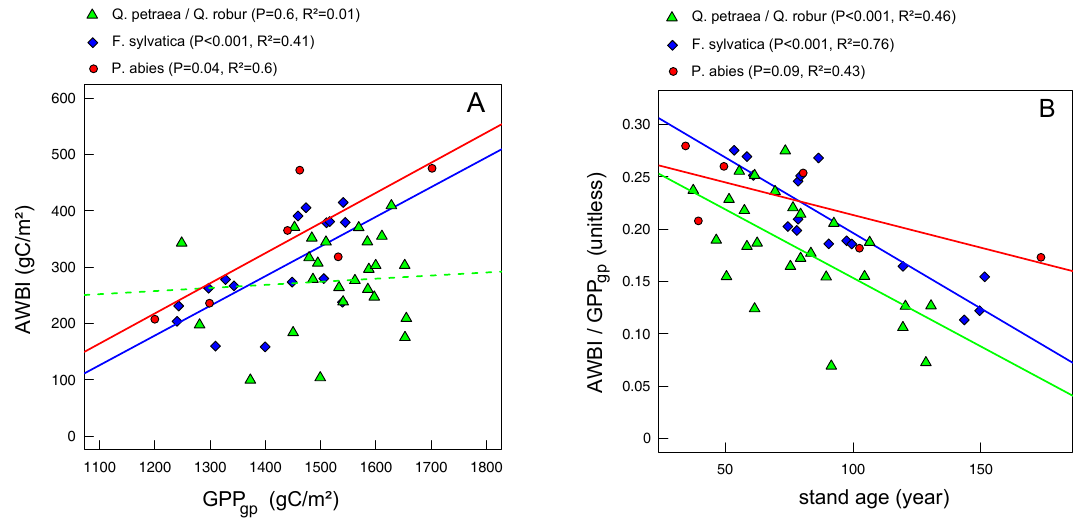
Figure 3. Spatial dependences of annual wood growth. (a) Relationship of the AWBI and the GPP of the growth period (GPP gp ) averaged over sites. (b) Age-related decline of the C partitioning to AWBI (AWBI / GPP gp ). Table 5. Temporal dependences of the annual woody growth: multiple-regression estimates. Data have been centred and scaled. GPP gp is the gross primary production of the growth period, WS_per gp is a water stress index of the growth period, WS_int y − 1 is a water stress index of the previous year, templim is a low temperature index of the growth period (Table 2). D 1 and D 2 are dummy variables ( D 1 = 0 if GPP gp < 1400gCm − 2 , D 1 = 1 otherwise; D 2 = 0 if GPP y − 1 < 1550gCm − 2 , D 2 = 1 otherwise; see Fig. 5). ρ is the parameter of the first-order autoregressive process used to model the temporal autocorrelation of within-stand errors. Values: estimates [ F values]. Estimate values differing from 0 are indicated ( ∗ P < 0 . 05, ∗∗ P < 0 . 01, ∗∗∗ P < 0 . 001). The estimate with a (cid:49) index indicates variable not retained in the bootstrap procedure (see main